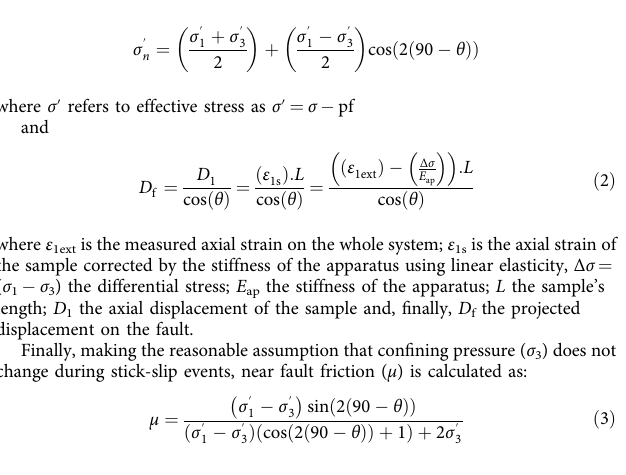
Methods Starting material . Samples were WG cylinders (Supplementary Fig. 1) (40 mm diameter and 88 mm length). This material was selected because it is simple in composition, it is representative of the continental crust and because of its very fi ne grain (<1mm), perfect homogeneity, isotropy and low alteration degree. A thermal treatment at atmospheric pressure was performed on the samples in order to increase the samples' crack density (i.e. permeability) and so to allow good saturation and reasonable fl uid diffusion times in the samples. Samples were heated at a gradient of 5°C min − 1 up to 450°C. Then the target temperature was kept constant for 2h. Finally, the furnace was turn off and the samples were let to cool down overnight. The temperature ramp imposed in the furnace allowed having no